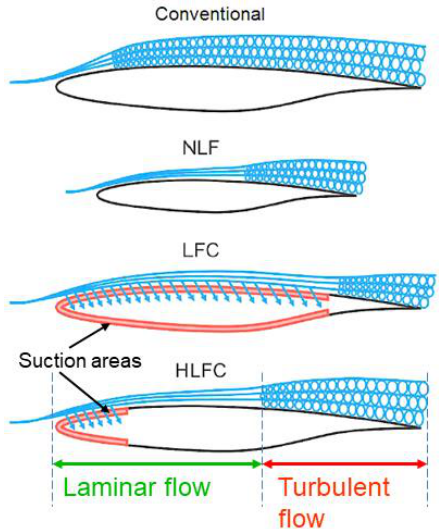
Figure 1. Comparison of NLF, LFC, and HLFC techniques—image adapted from [10] .